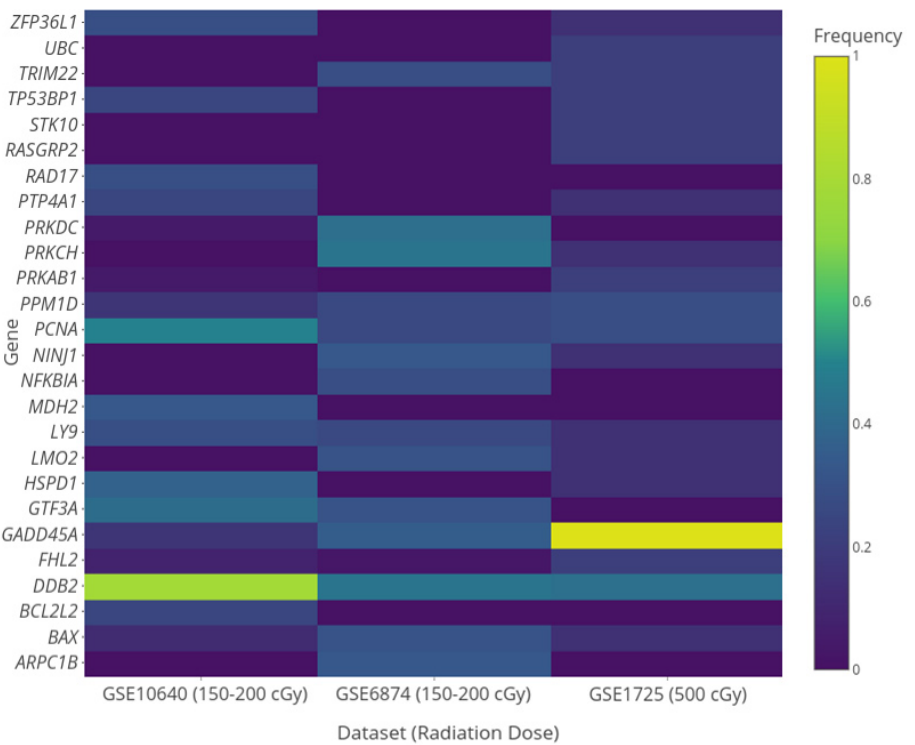
Figure 6. Heat map depicting the gene compositions of the top 20 human signatures derived at different radiation doses: 150-200 cGy (GSE10640[GPL6522], GSE6874[GPL4782]) and 500 cGy (GSE1725). Frequencies are first scaled within and then between datasets to ensure values between 0 and